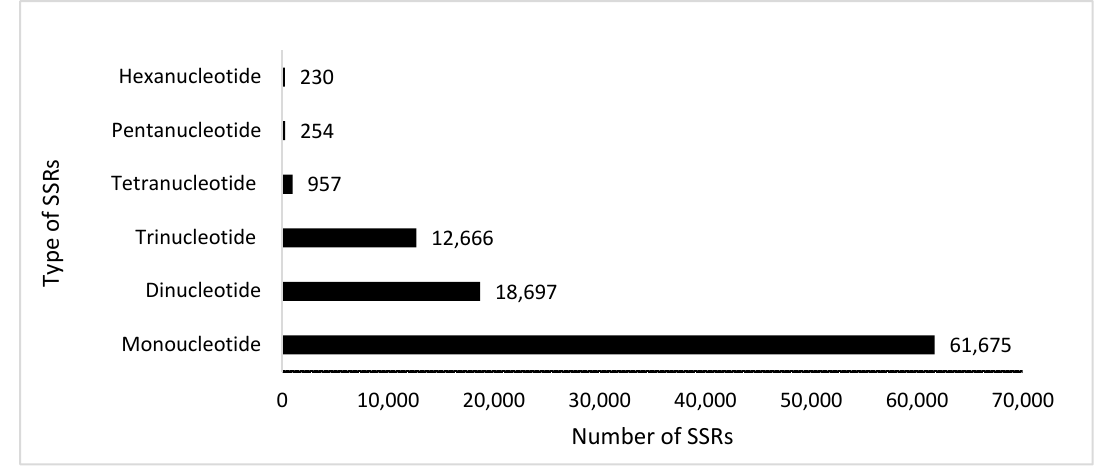
Figure 3. Simple sequence repeats (SSRs) classes identified in the leaf transcripts of A. marmelos .